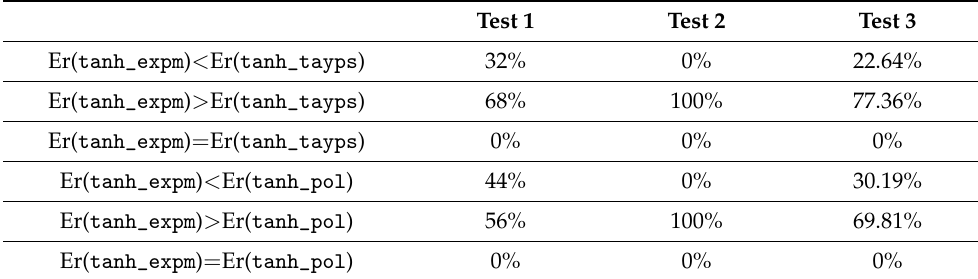
Table 3. The relative error comparison, for the three tests, between tanh_expm vs. tanh_tayps and tanh_expm vs tanh_pol